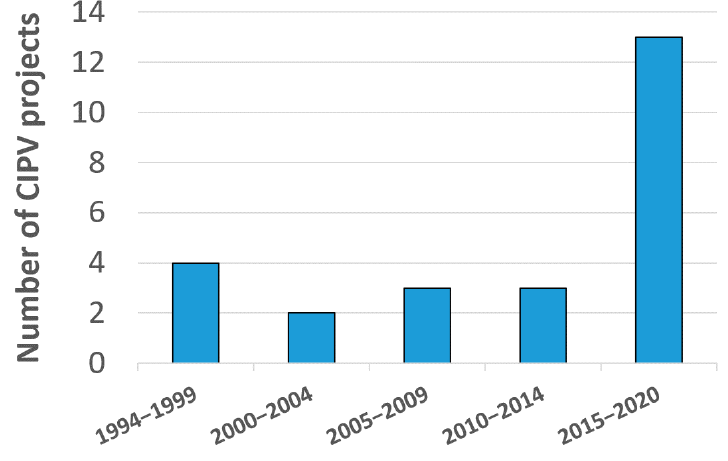
Figure 3. Number of CIPV projects over time.